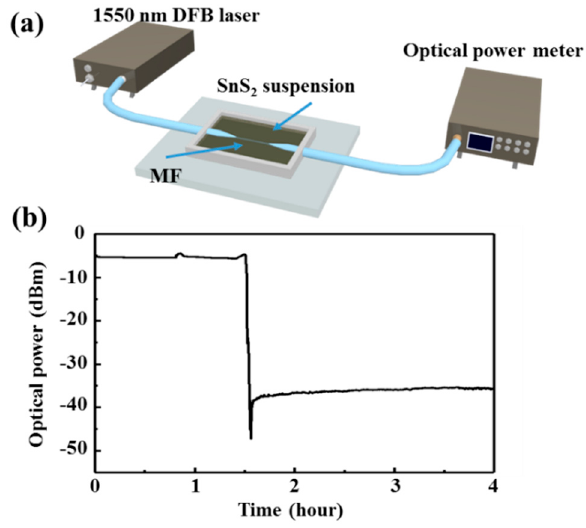
Figure 3. ( a ) Schematic setup of the deposition of SnS 2 on MF. ( b ) Variation of transmitted optical power in MF during the deposition of SnS 2 nanosheets onto the MF. The fabricated MF coated with SnS 2 is imaged by scanning electron microscopy (SEM).